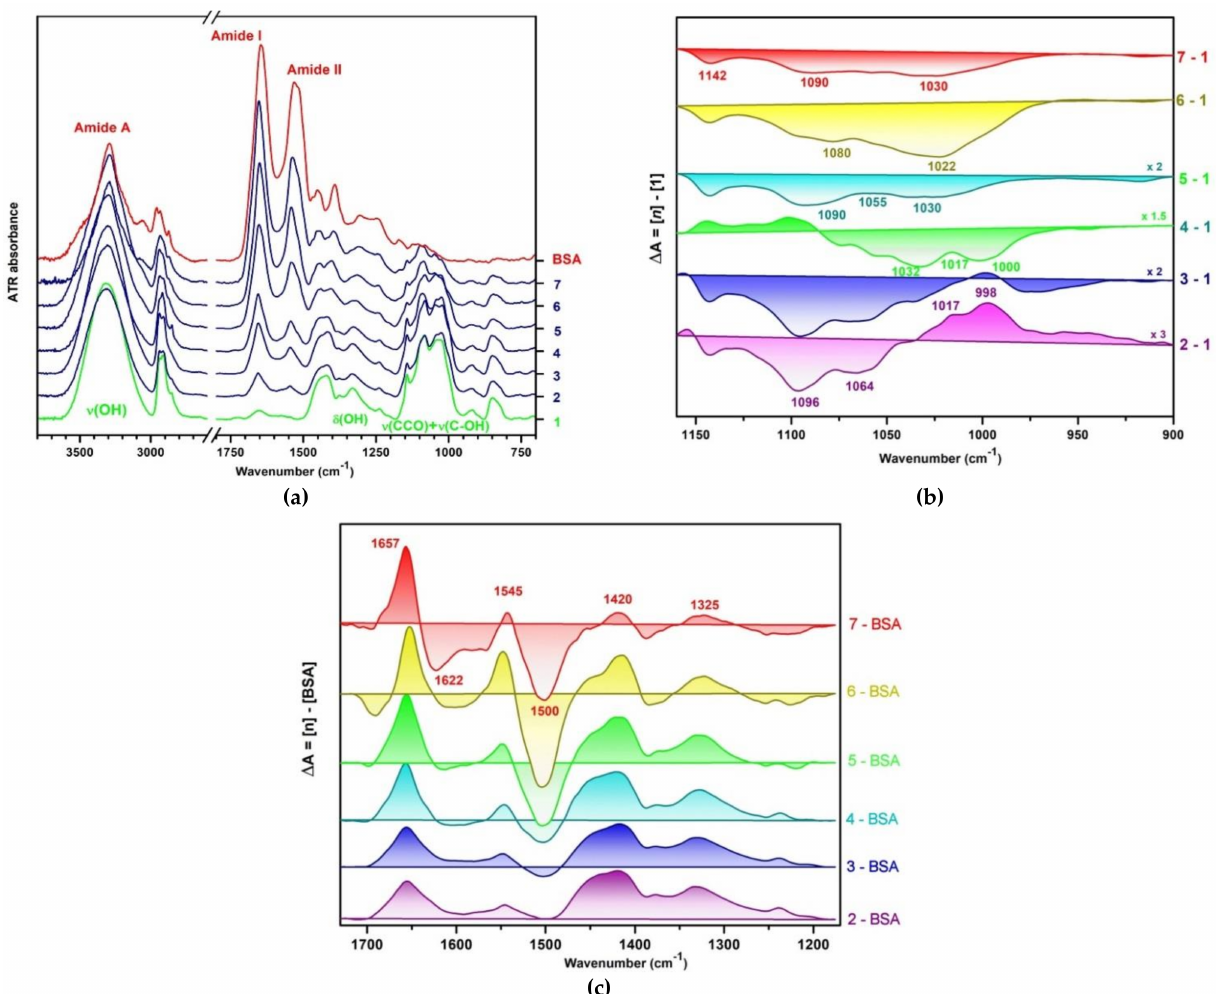
Figure 2. ( a ) FTIR spectra of PULL/PVA in absence and presence of BSA, compared to the BSA spectrum. ( b ) The difference spectra [sample n]—[sample 1] (n = 2 ÷ 7) in the ν (C-OH)+ ν (C-C-O) area. ( c ) The difference spectra [sample n]—[BSA] (n = 2 ÷ 7)) in the Amide I—Amide III